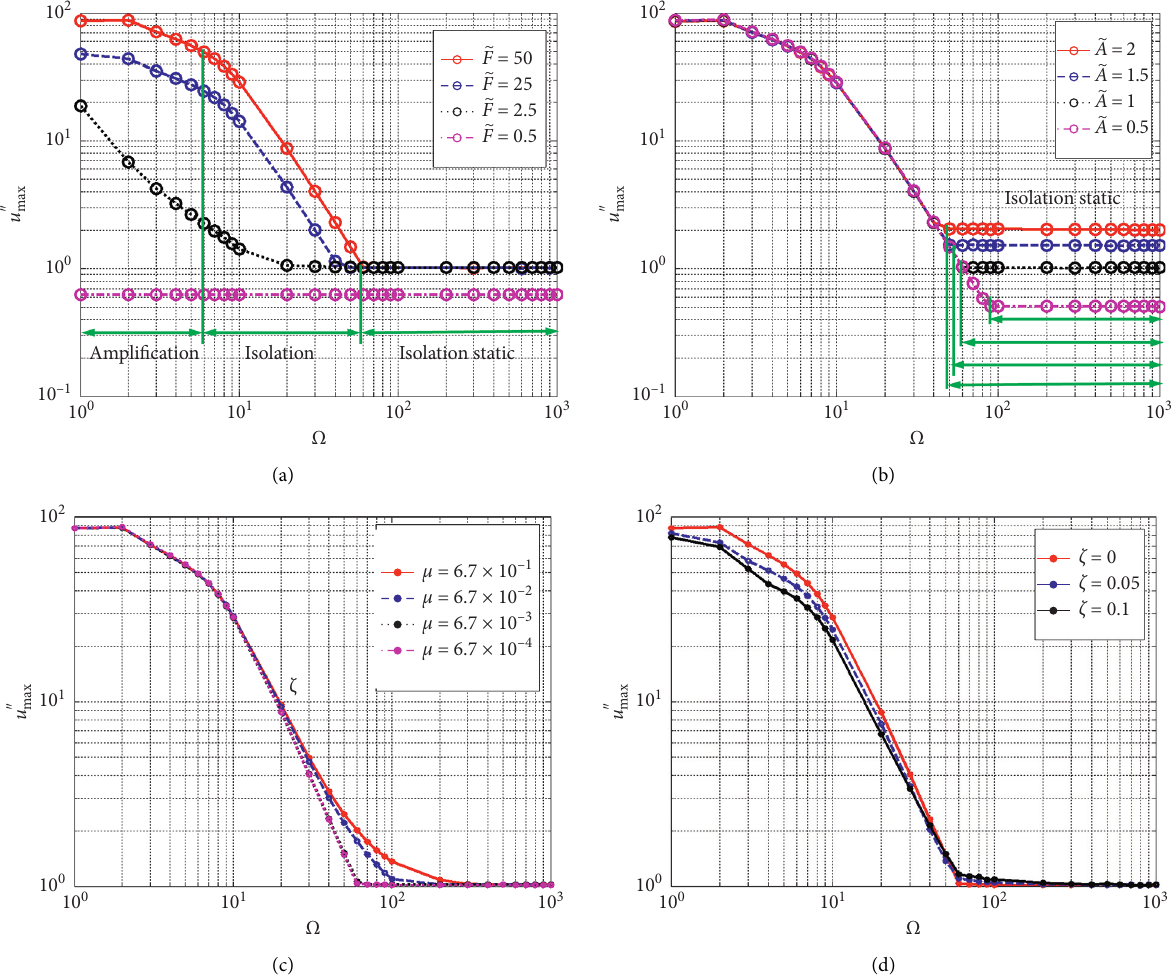
Figure 7: The streamslice of the NSA with different values of the % A and μ ( ζ � 0.05). (a) 􏽥 A � 0 . 01, μ � 1. (b) 􏽥 A � 0 . 1, μ � 1. (c) 􏽥 A � 1, μ � 1. (d) 􏽥 A � 1, μ � 0.1. (e) 􏽥 A � 1, μ � 2. (f) 􏽥 A � 1, μ �